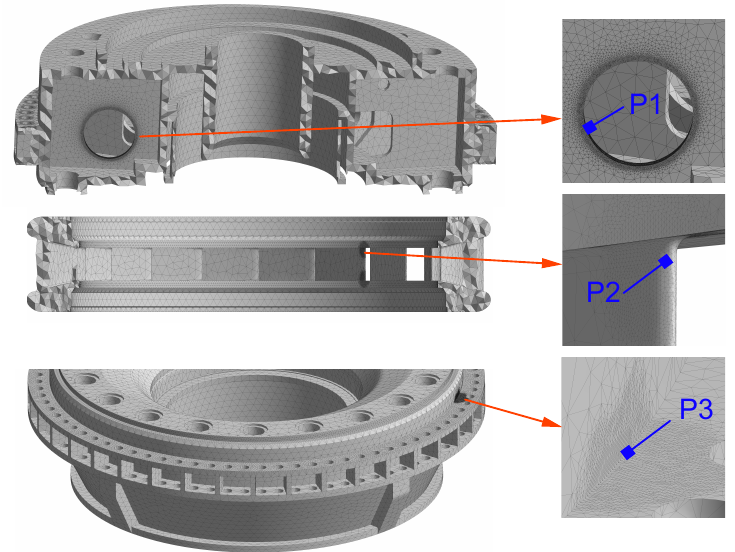
Figure 13. Structural mesh of the stationary structure of the PT unit.